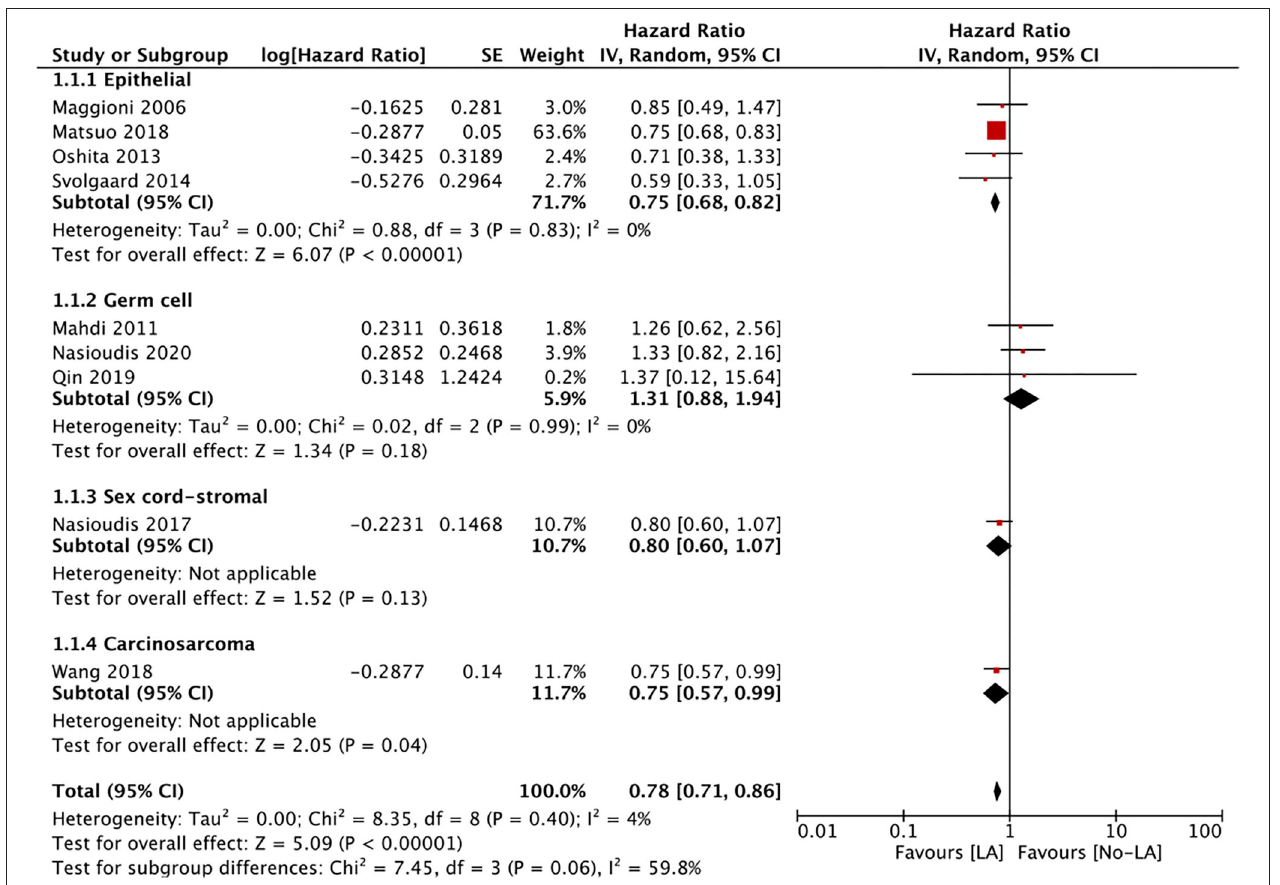
FIGURE 2 | Meta-analysis of OS for ESOC between lymphadenectomy and control groups with sub-group analysis based on type of